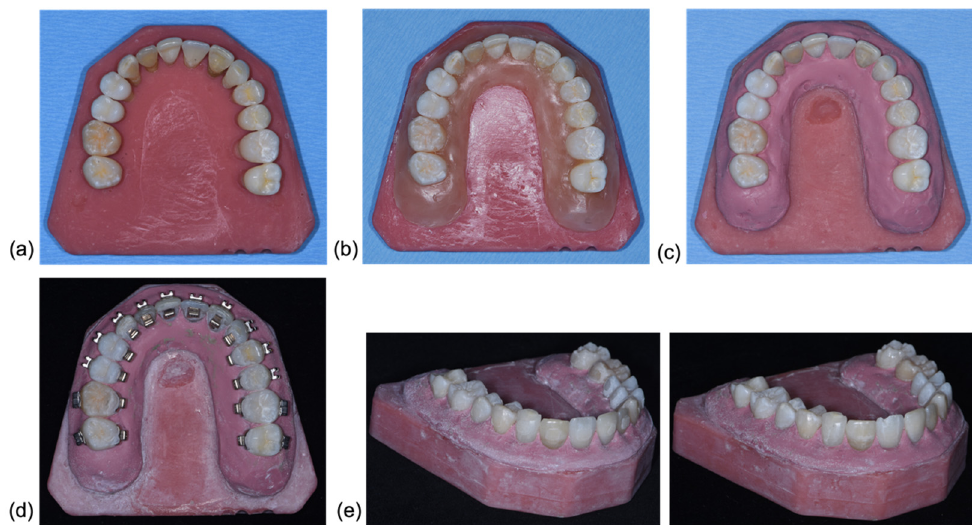
Figure 1. ( a ) Tooth set-up in polymer base. ( b ) Gingival mask made from wax was shaped to embed all teeth. ( c ) Wax base substituted with silicon base. ( d ) Teeth bonded buccal and lingual with their respective fixed appliances. ( e ) Upper model after bracket removal ( left ) and after surface clean up ( right ).